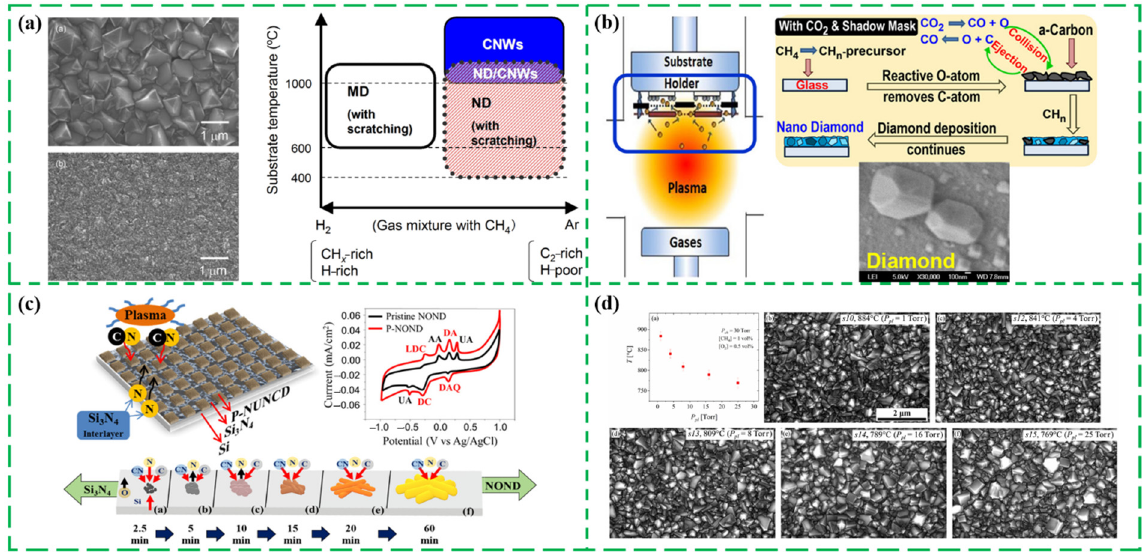
Figure 3. The synthesized ND films via microwave plasma CVD. ( a ) The SEM images of microdia- mond film and ND films, and the corresponding variation of the samples as functions of substrate temperature and gas composition [69]. ( b ) Schematic diagram of the active plasma zone and the growth process of the low-temperature nano-/microcrystalline diamond growth [70]. ( c ) The for- mation evolution process and the CV scans of the ND film [71]. ( d ) The relationship curves between the average substrate temperature and the plenum pressure P pl , and the SEM images of the corresponding samples [72].